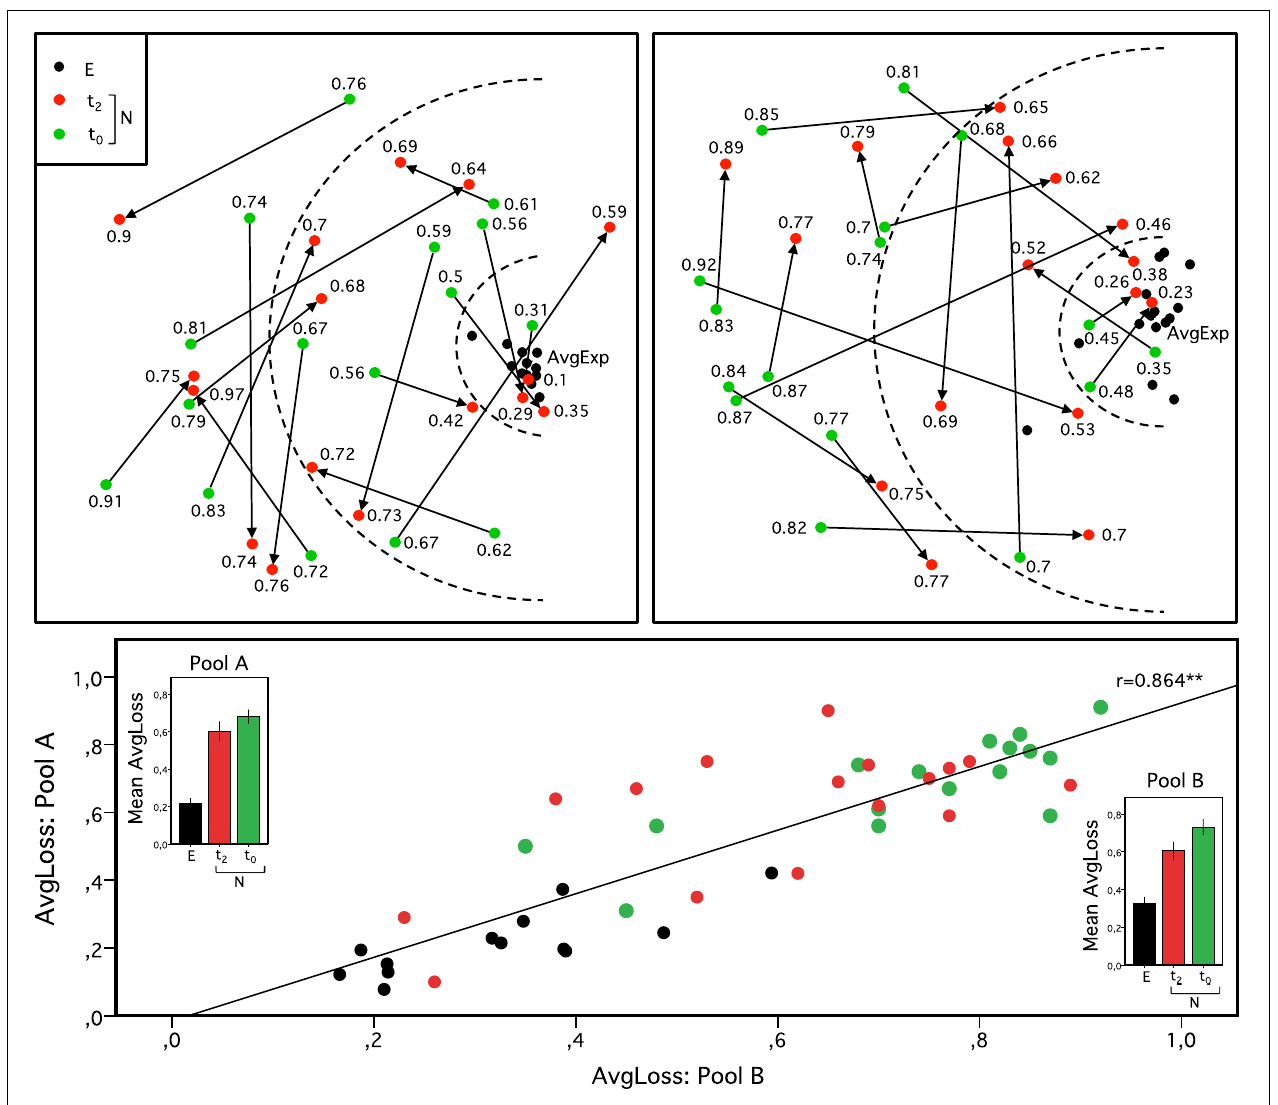
expert model and individual experts are clustered on the right hand side of the both LOMMs.The two semi-circles imply the interpretative differentiation between novices’ good and moderate maps (inner semi-circle) and between moderate and poor maps (outer semi-circle) in relation to the experts’ maps. The lower part of this figure displays the distribution of AvgLoss of experts (E) and novices (N) at timepoints t 0 and t 2 in relation to the mean expert models (pool A/B). Histograms represent the mean AvgLoss for each group and separately for both pools (whiskers indicate standard errors of the mean).The significant correlation (including all groups, n = 45) indicates overall intra-rater consistency in performance across Pool A and B ( r = 0.863, ** p <